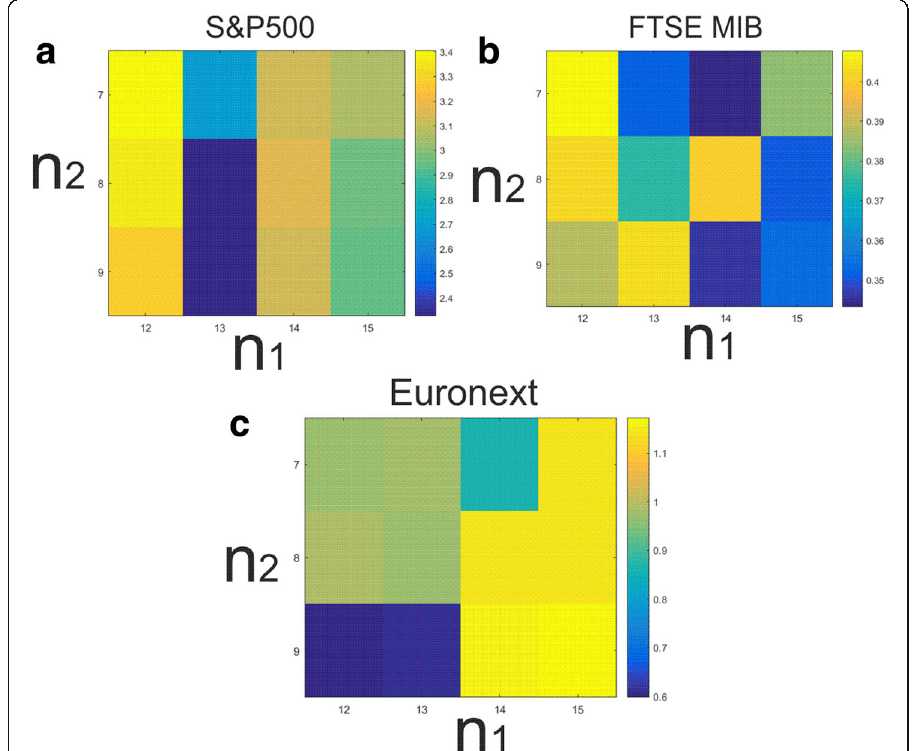
Fig. 4 Cumulative returns obtained at the end of the time sample for different values of the parameters n 1 and n 2 . Panel a represents the end-of-sample cumulative performance obtained in forecasting the dynamic of the 388 stocks of the first dataset (S&P500) . Panel b shows the end-of-sample cumulative performance obtained by the signal-optimized portfolio strategy in forecasting the dynamic of the 59 stocks of the second dataset (FTSE MIB). Panel c encompasses the cumulative returns obtained by the signal-optimized portfolio strategy in forecasting the dynamic of the 156 stocks of the third dataset (Euronext Paris stock exchange). The cumulative returns are positive for all parameter configurations suggesting some robustness of the proposed methodology against different setting of the